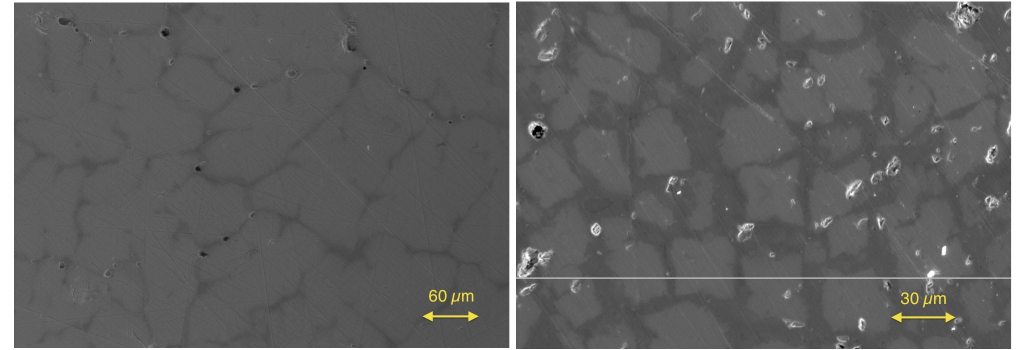
Figure 7. Scanning electron microscope images of Ti 0.2 Hf 0.8 NiSn ( left ) and Ti 0.7 Hf 0.3 NiSn ( right